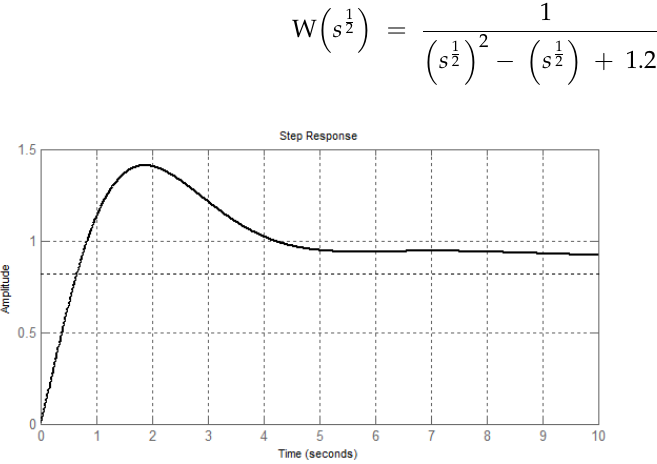
Figure 8. The transition function in this case.